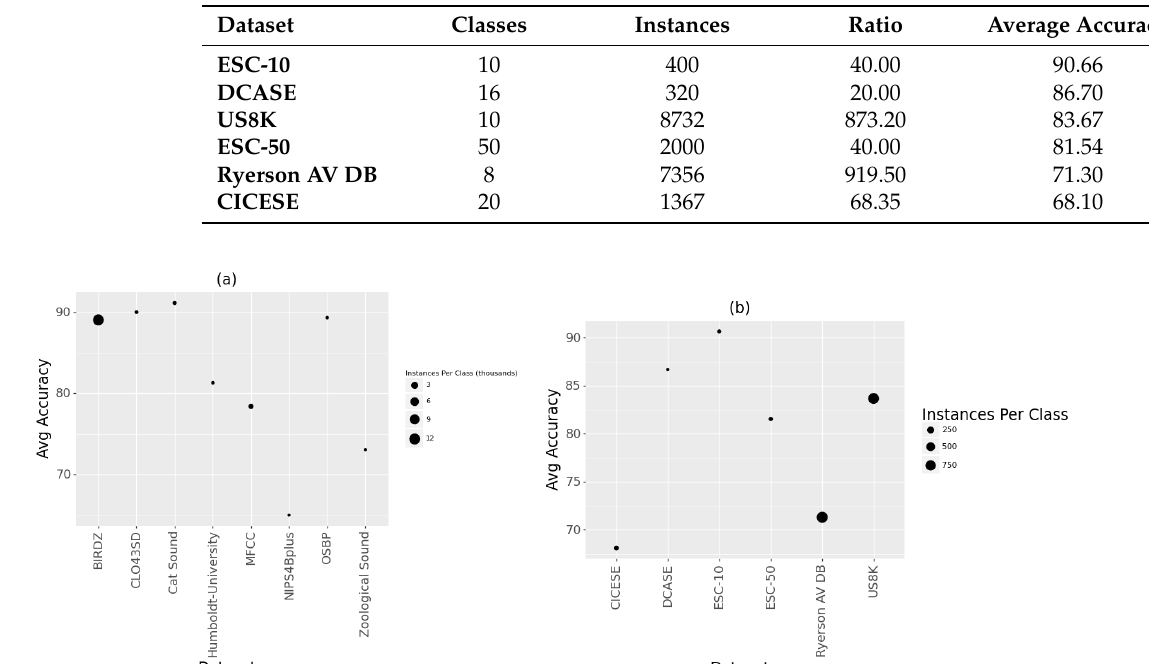
Table 5. General acoustics dataset size and classification accuracy.